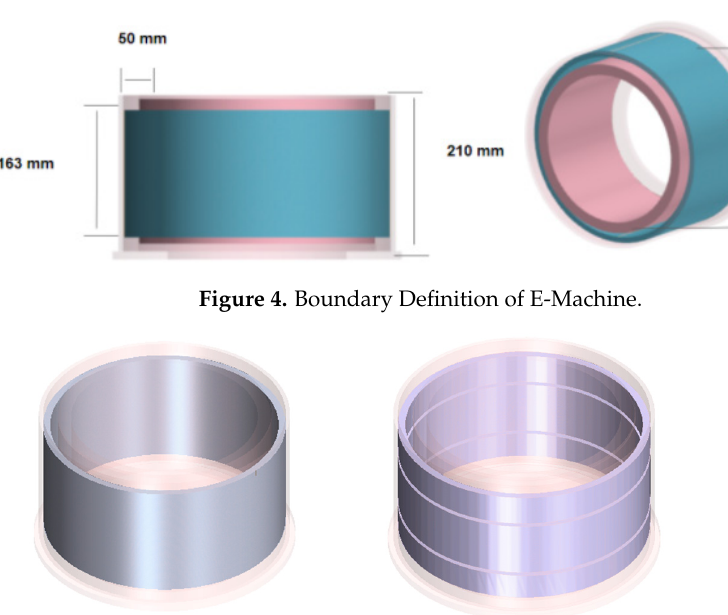
Figure 3. Symmetric diagram of E-Machine.